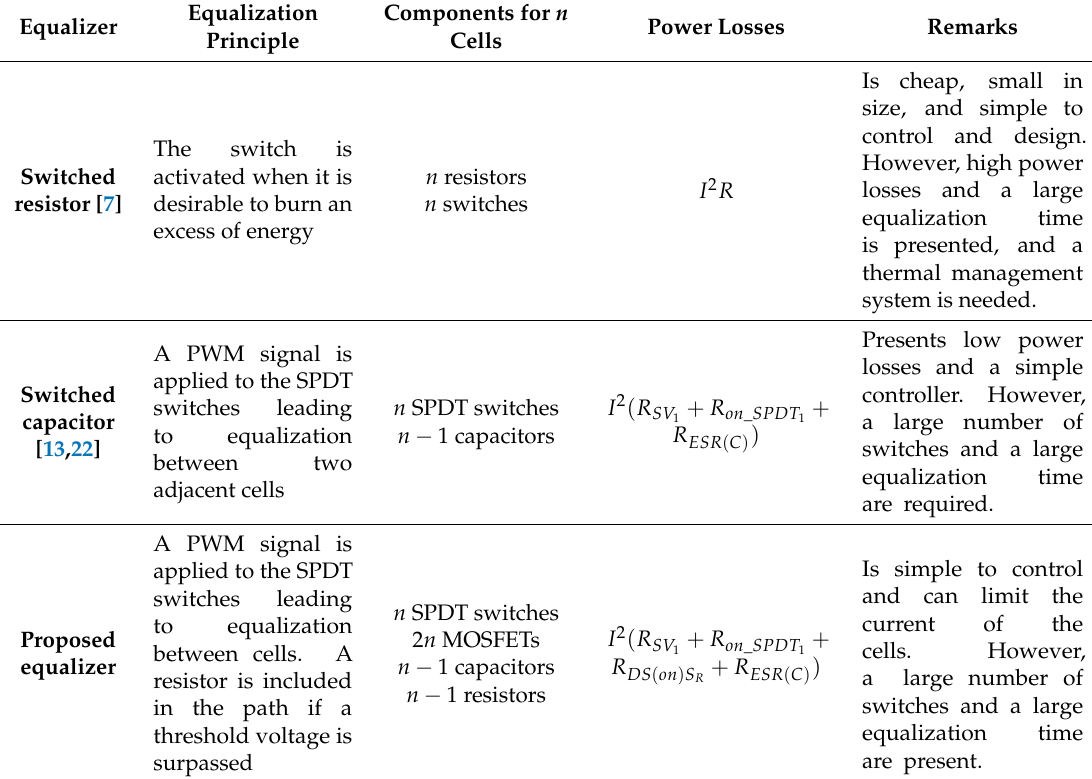
Table 3. Comparative analysis of several BECs.